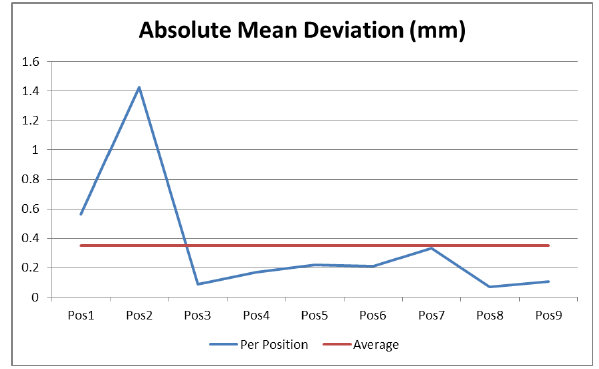
Figure 13. Mean point deviations in mm, indirect